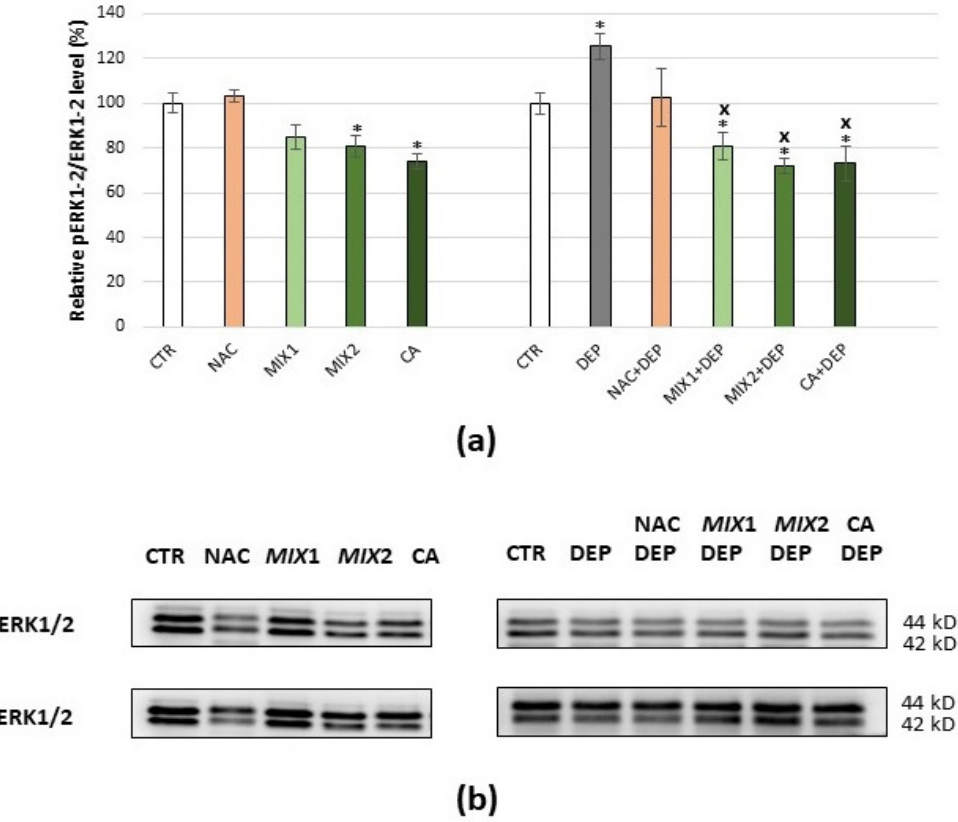
Figure 6. Immunoblotting analysis of total ERK1/2 phosphorylated/ERK1/2 ratio. ( a ) Protein was evaluated following cell treatment carried out only with antioxidants (5 mM NAC for 24 h, 0.5 µ M Mix 1 or 1 µ M Mix 2 or 1 µ M caffeic acid (CA) for 48 h), only with pro-oxidant (25 µ g/mL DEPs for 12 h), and finally with the different antioxidants and subsequent exposure to DEPs. Protein ratio is expressed as a percentage of the control. Values represent mean ± SE obtained from three independent experiments. * p < 0.05 versus control, X p < 0.05 versus DEP treatment. ( b ) Corresponding representative immunoblotting images.